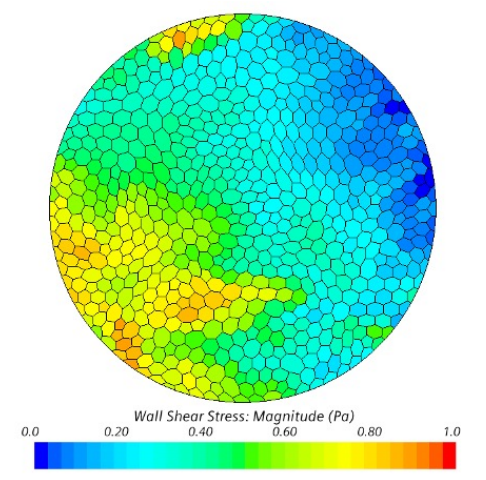
Figure 2. Example of the polygonal mesh on one of the coupon surfaces, colored by the wall shear stress from an arbitrary snapshot in time. Baffle motion and the average fluid flow are from left to right.